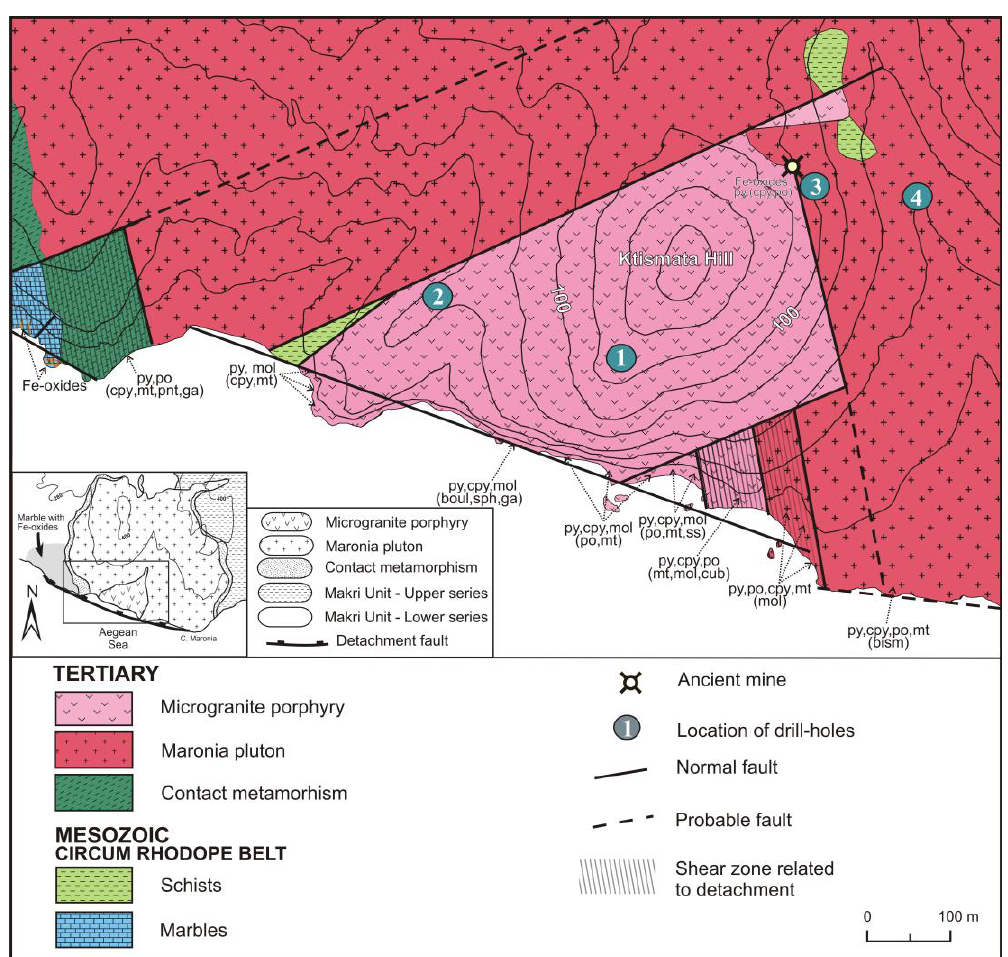
Figure 2. Geological sketch map of the porphyry Cu-Mo-Re ± Au deposit of Maronia showing the mineralization occurrences (modified from [11]). mt: magnetite; py: pyrite; po: pyrrhotite; pnt: pentlandite; cpy: chalcopyrite; mol: molybdenite; sph: sphalerite; ga: galena; cub: cubanite; bism: bismuthinite; boul: boulangerite; ss: Cu-Pb-(Sb + As) sulfosalts (bournonite, boulangerite, tetrahedrite-tennantite, chalcostibite, zinkenite, famatinite); Fe-oxides: goethite and hematite.